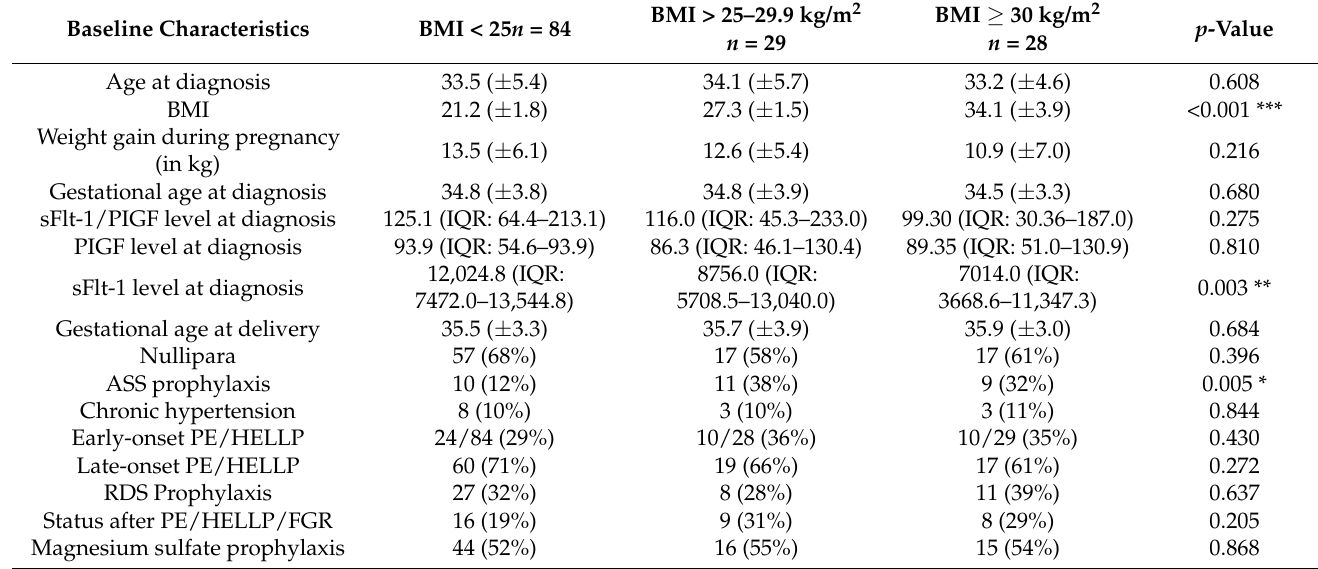
Table 1. Baseline characteristics.